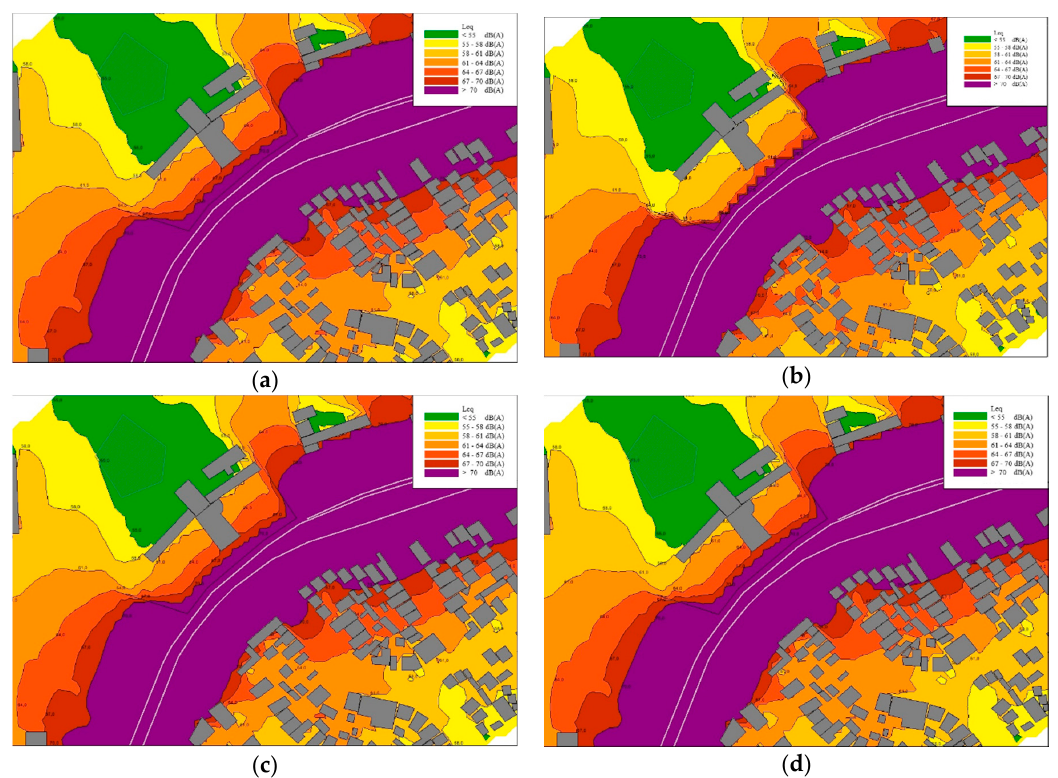
Figure 7. Noise map calculated with Medianeira School under different conditions: ( a ) With a 3 m high raw concrete noise barrier; ( b ) With a 5 m high raw concrete noise barrier; ( c ) With a 3 m high raw concrete noise barrier insulated with rockwool; and ( d ) With a 5 m high raw concrete noise barrier insulated with rockwool.